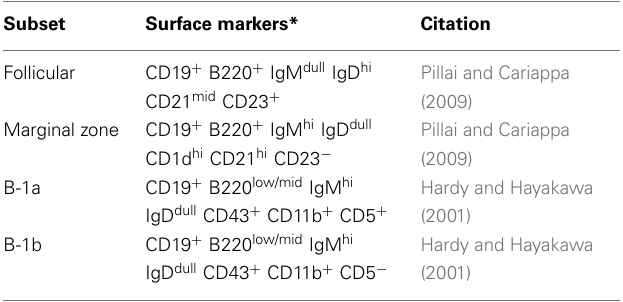
Table 1 | B cell subset